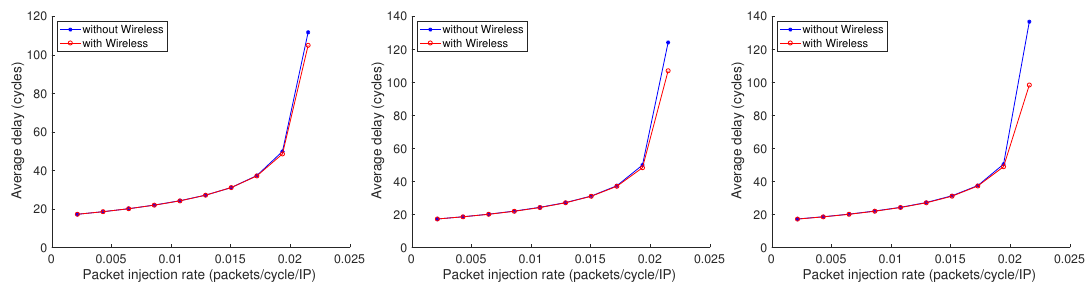
Figure 5. From left to right: Average delay for profiles T 4 , T 8 , and T 16 for 64 Delta MIN topology and random traffic (TR-64 Delta MIN).